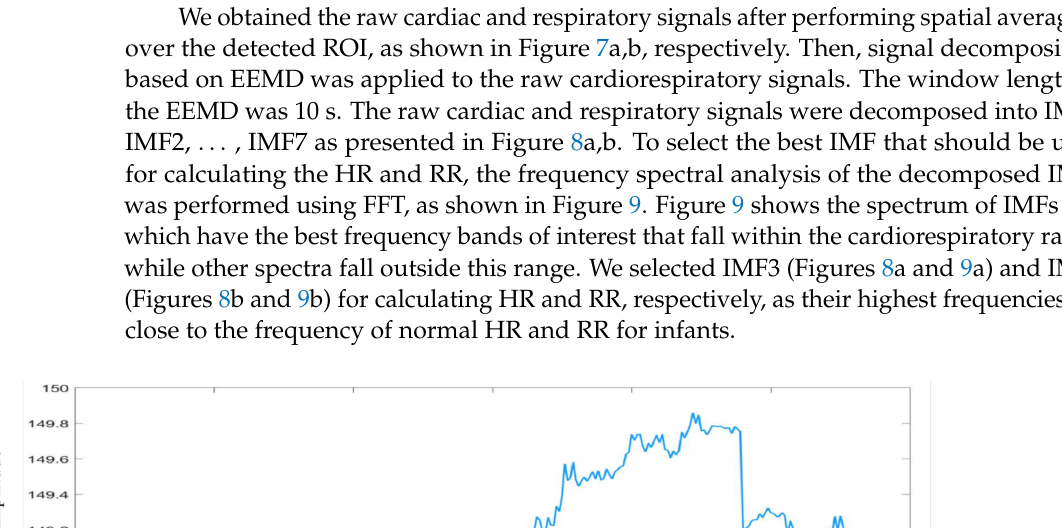
Figure 6. An infant image with detected ROI is shown in ( a ). The corresponding ROI extracted from the original is shown in ( b ).